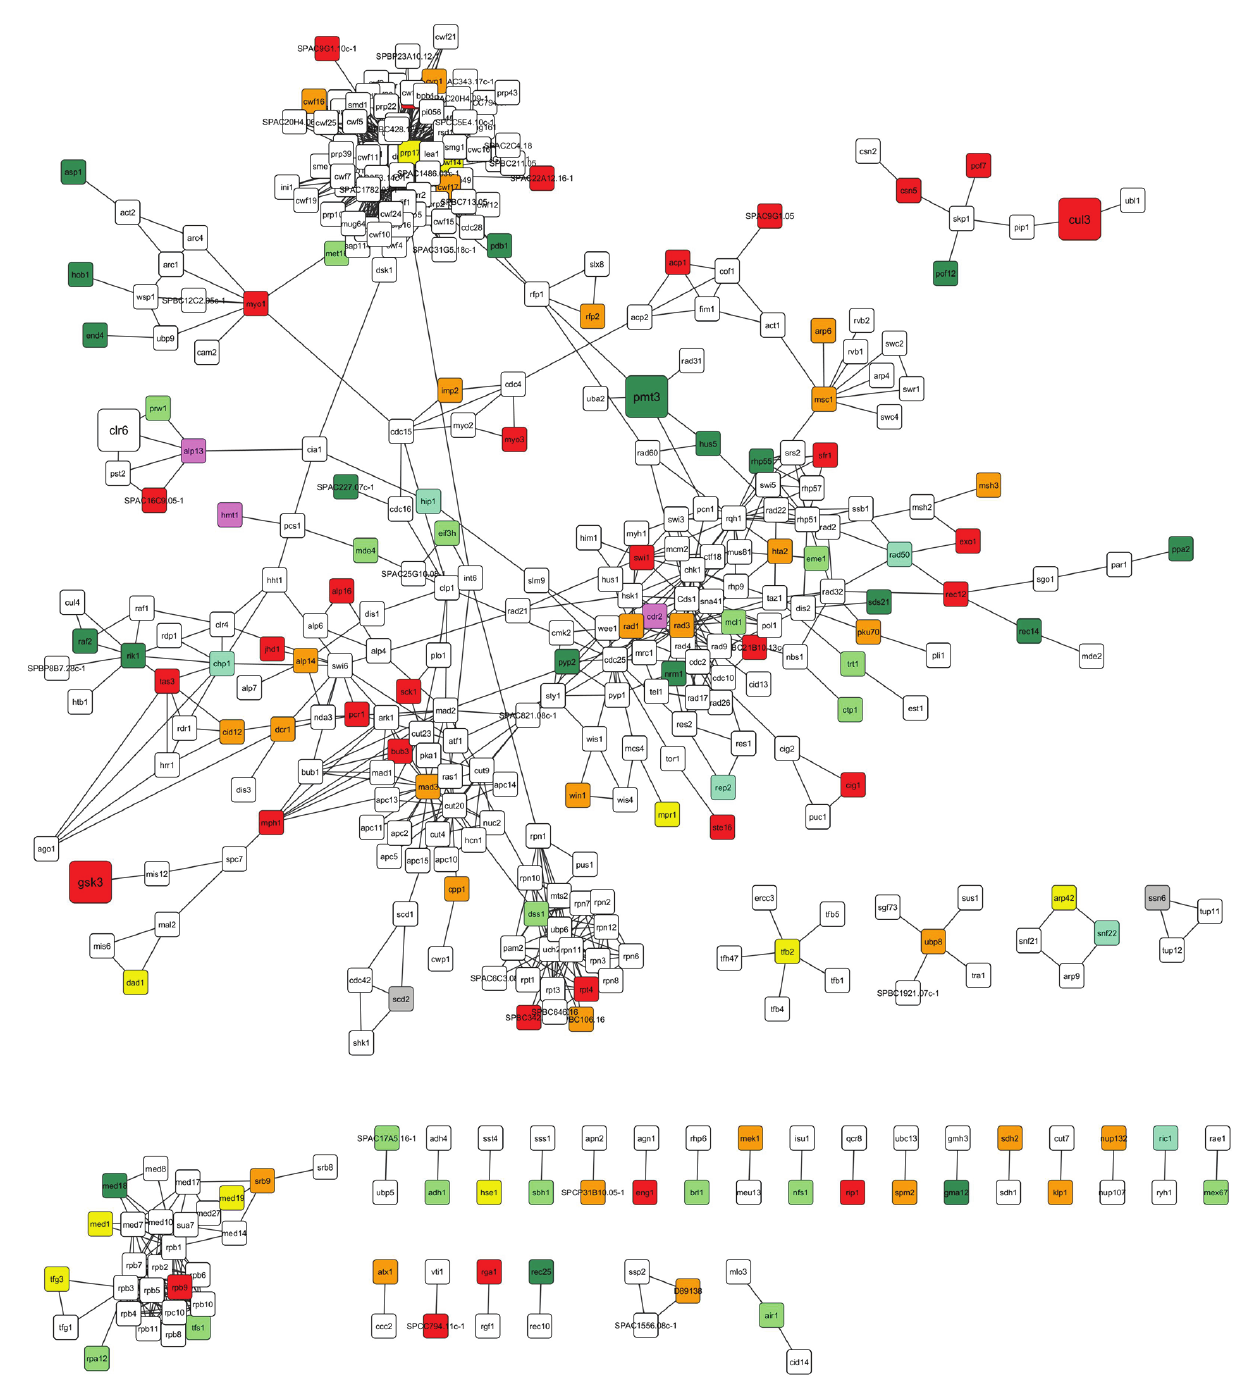
Figure S1. S. pombe extended UBA1 interaction network (complete). The full protein-protein interaction network including first-degree neighbors for all fission yeast gene modifiers identified from our two independent SGA